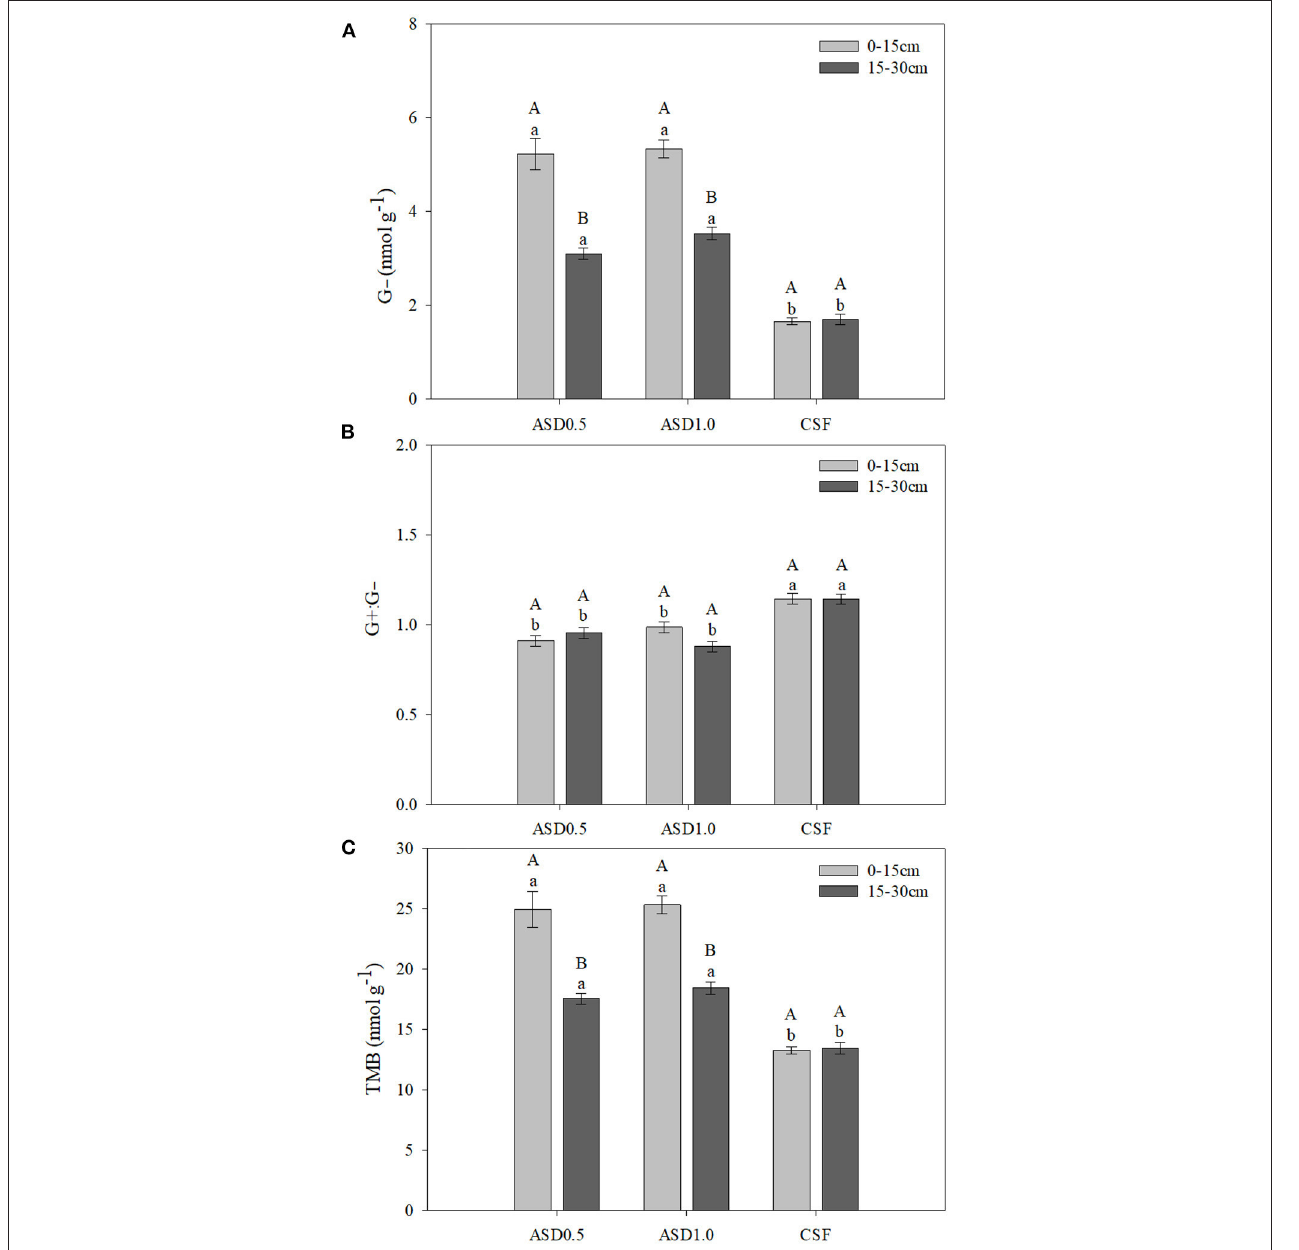
FIGURE 1 | Bulk soil PLFA concentrations of G − bacteria (A) , ratio of G + :G − (B) , and PLFA concentrations of TMB (C) as affected by the two-way interaction of soil treatment and soil depth across sampling dates. Error bars represent standard error. Within a soil treatment, bars sharing the same uppercase letter are not significantly different at P ≤ 0.05 according to Tukey’s HSD test. Within a sampling depth, bars sharing the same lowercase letter are not significantly different at P ≤ 0.05 according to Tukey’s HSD test. CSF, chemical soil fumigation control with Pic-Clor 60 at a rate of 224kg ha − 1 ; ASD0.5, anaerobic soil disinfestation with 6.9 m 3 ha − 1 of molasses and 11Mg ha − 1 of composted poultry litter; ASD1.0, anaerobic soil disinfestation with 13.9 m 3 ha − 1 of molasses and 22Mg ha − 1 of composted poultry litter. G − , Gram negative bacteria; G + :G − , ratio of Gram positive bacteria to Gram negative bacteria; TMB, total microbial biomass.